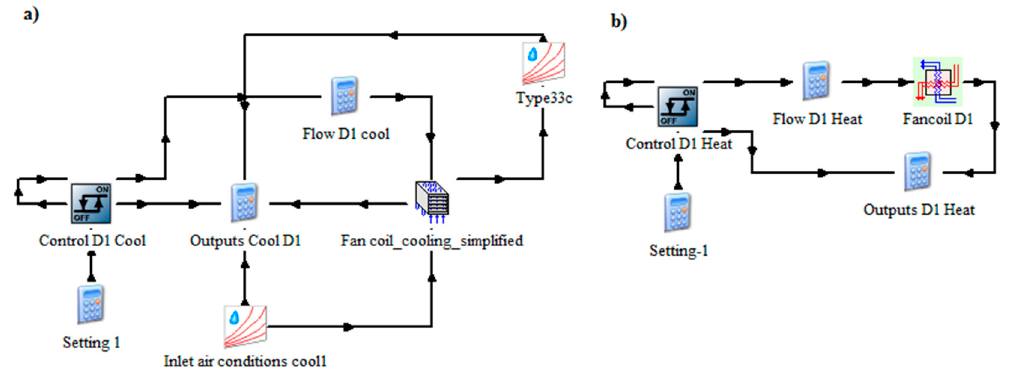
Figure 4. Fancoils model in TRNSYS: ( a ) cooling, and ( b ) heating.